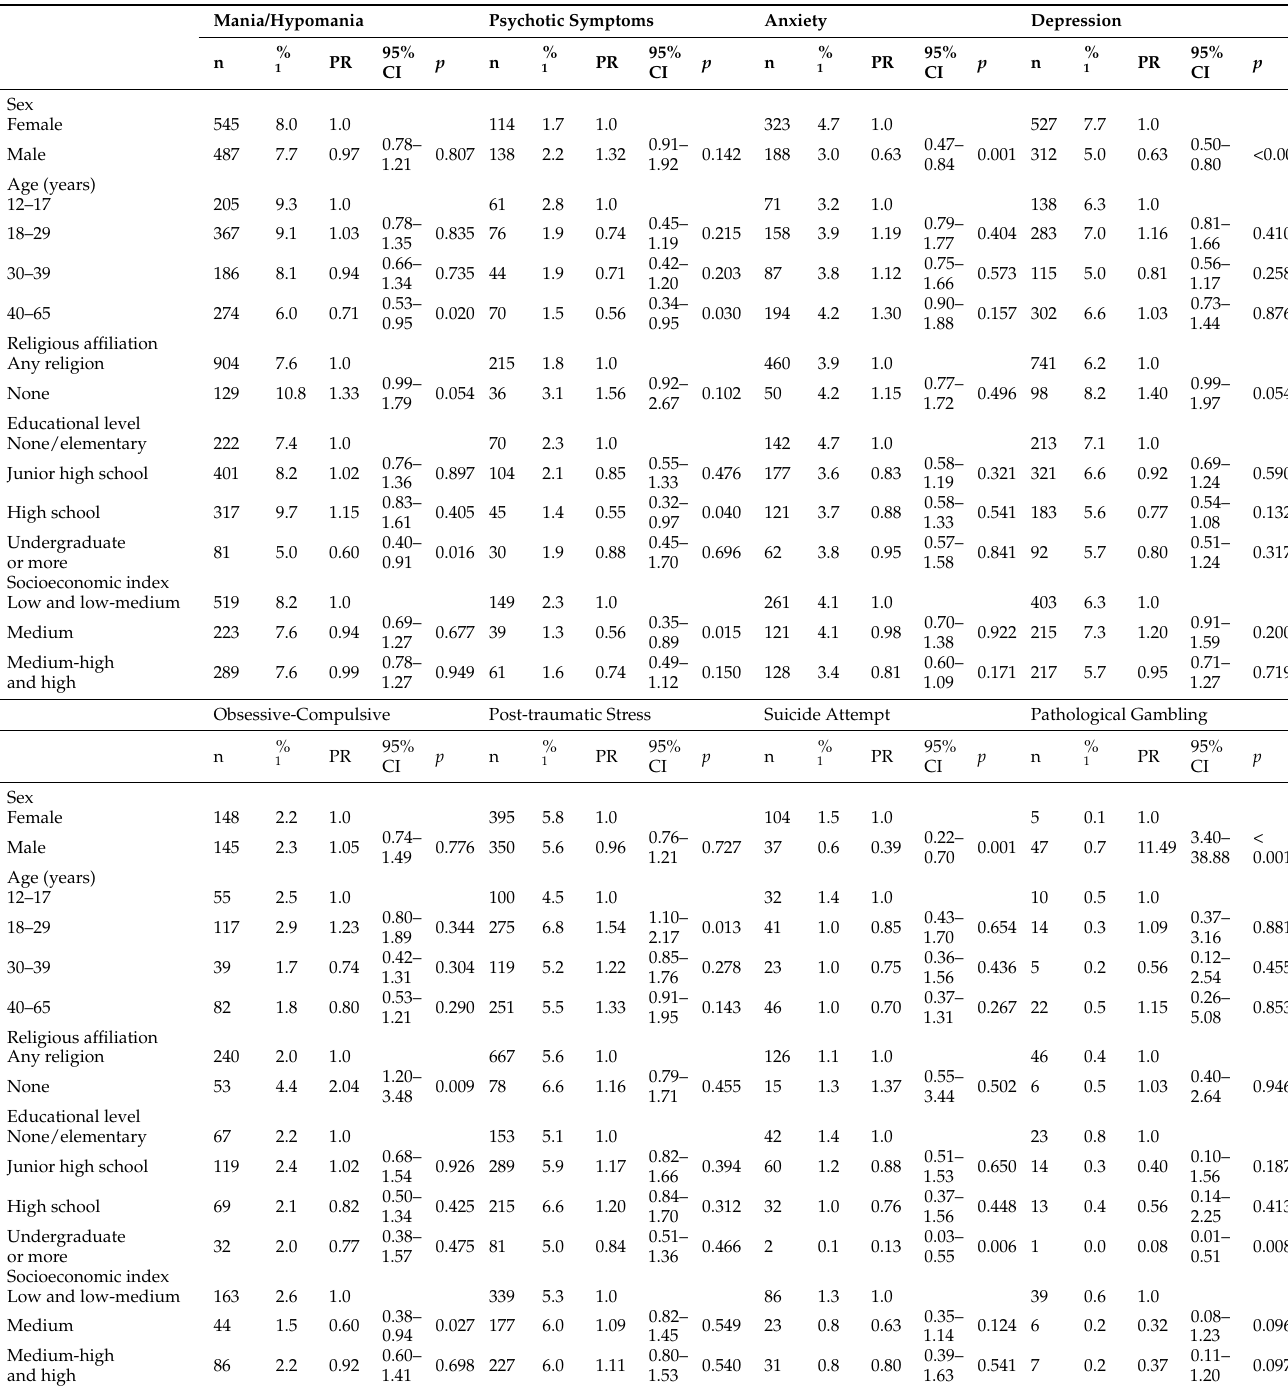
Table 3. Predictors of mental illness